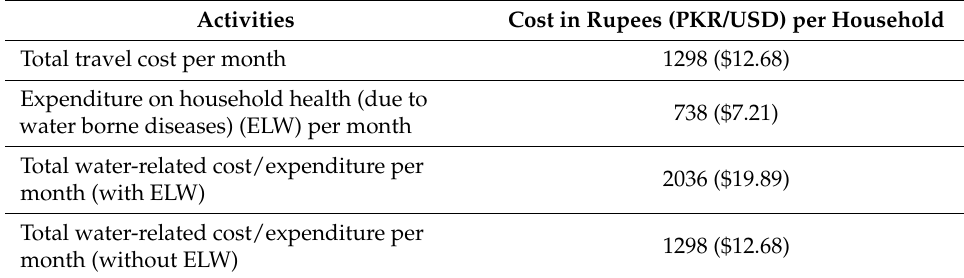
Table 4. Water-related cost